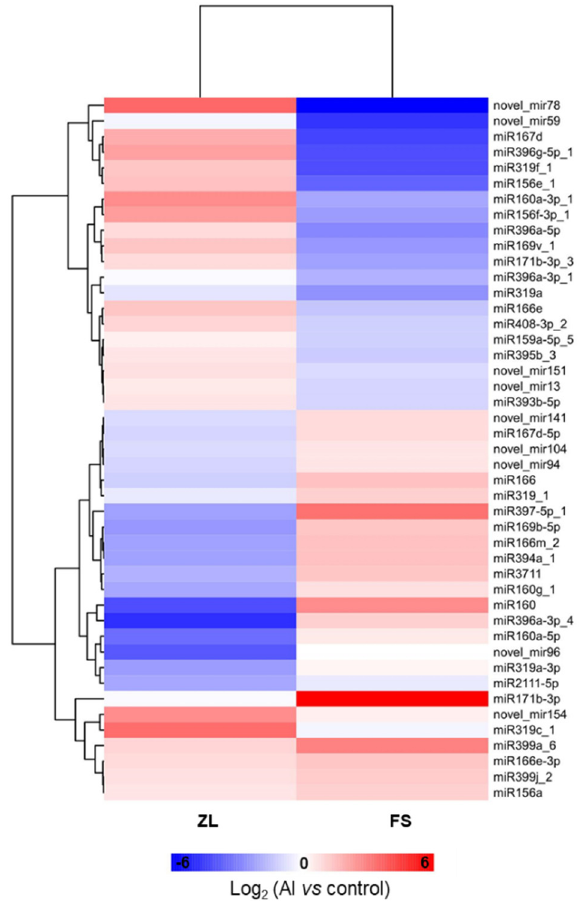
Figure 5. The hierarchical clustering analysis of Al-responsive miRNAs from roots of ZL and FS. Hierarchical clustering of differently expressed miRNAs was displayed by Euclidean distance and complete cluster methods as a measurement of similarity.